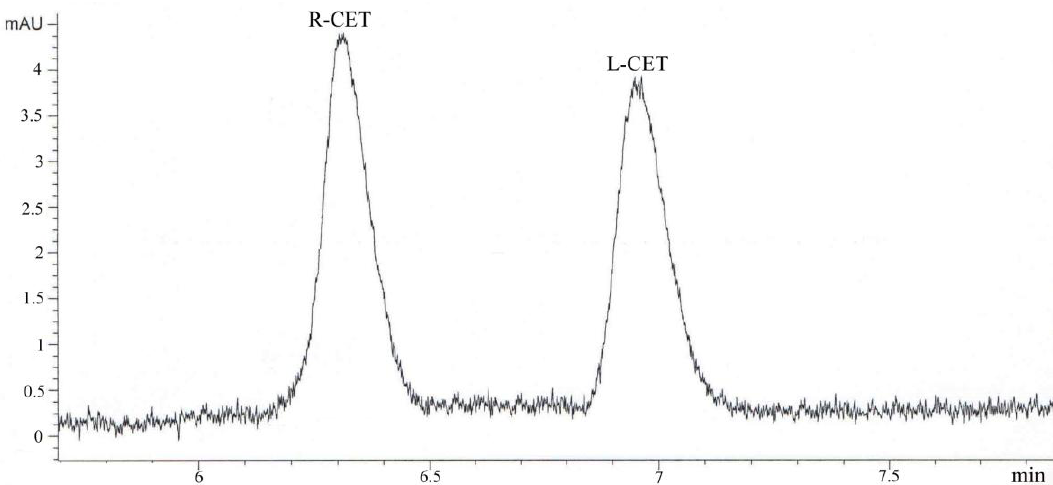
Figure 2. Capillary electrophoretic separation of CET enantiomers using SBE- β-CD as chiral selector (experimental conditions: BGE: 25 mM disodium hydrogenophosphate – 25mM sodium didydrogenophosphate (1:1), chiral selector: 5mM SBE- β-CD, pH–7.0, voltage + 20kV,